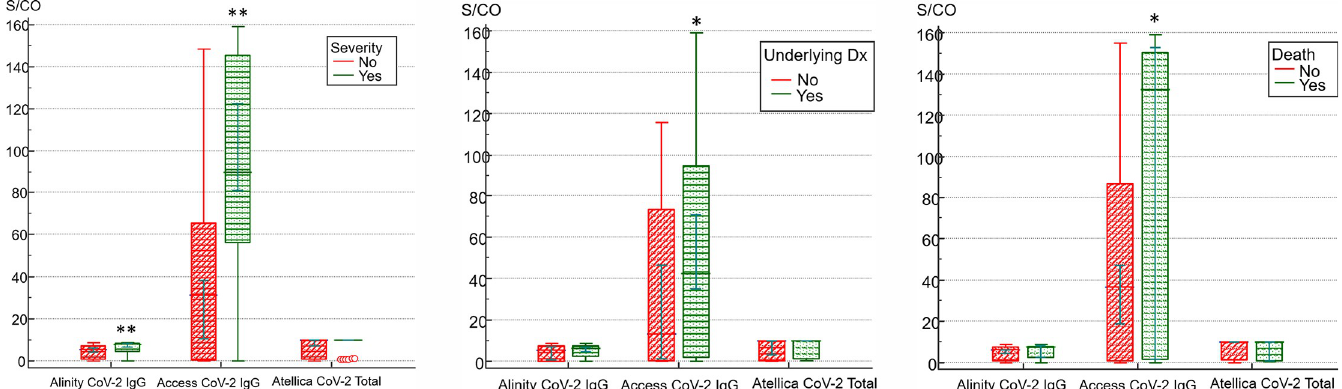
Fig 6. Mann-Whitney’s U comparison between (A) patients with severity and non-severe group (B) patients with and without underlying disease (C) patients classified by mortality. Access CoV-2 IgG antibody had a statistically significantly higher S/CO index in severe patients, patients with underlying disease, and patients who died. Alinity CoV-2 IgG antibody had a significantly more increased S/CO index in severe patients than in those of the non-severe group. � P < 0.05, �� P < 0.005.